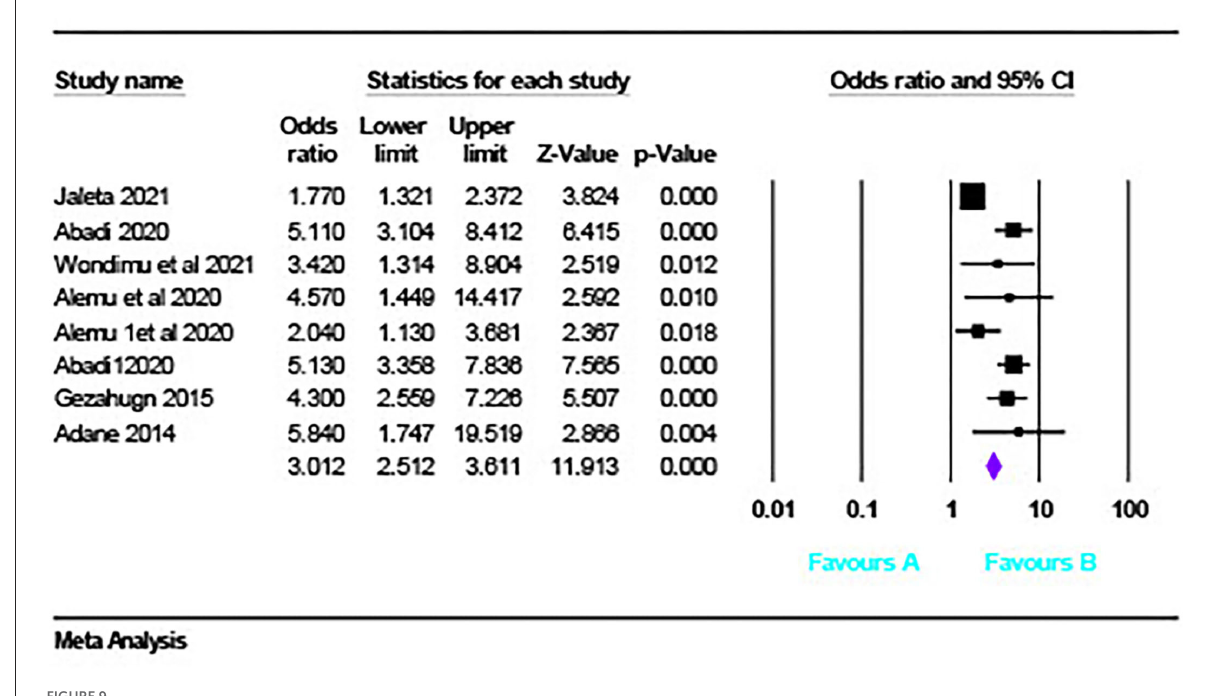
FIGURE9 Obstetrics emergency and adverse perinatal